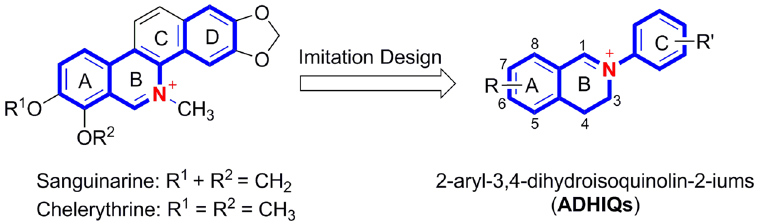
Figure 1. Structures of sanguinarine, chelerythrine and ADHIQs.